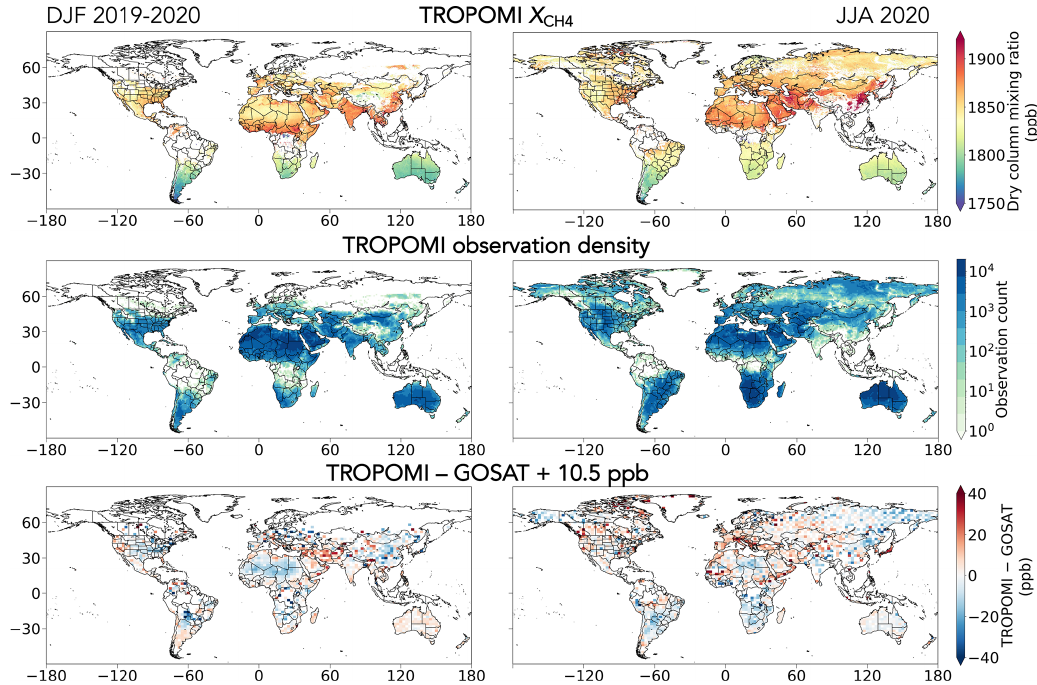
Figure 2. Global TROPOMI observations of methane for December 2019–February 2020 and June–August 2020. Data are from the